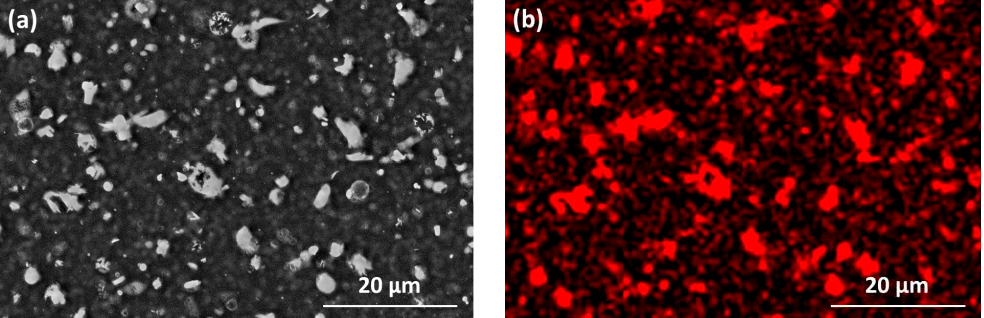
Figure 2. ( a ) SEM micrograph of the surface topography and ( b ) the corresponding Zn EDX mapping for a Zn-SiO x film grown on Si with a secondary precursor flow rate of 100 µl/min. Both austenitic stainless steel and TiAl6V4 substrates coated with Zn-SiO x and Cu-SiO x films exhibit a surface roughness R a determined using a stylus contact profilometer in the range of 480 to